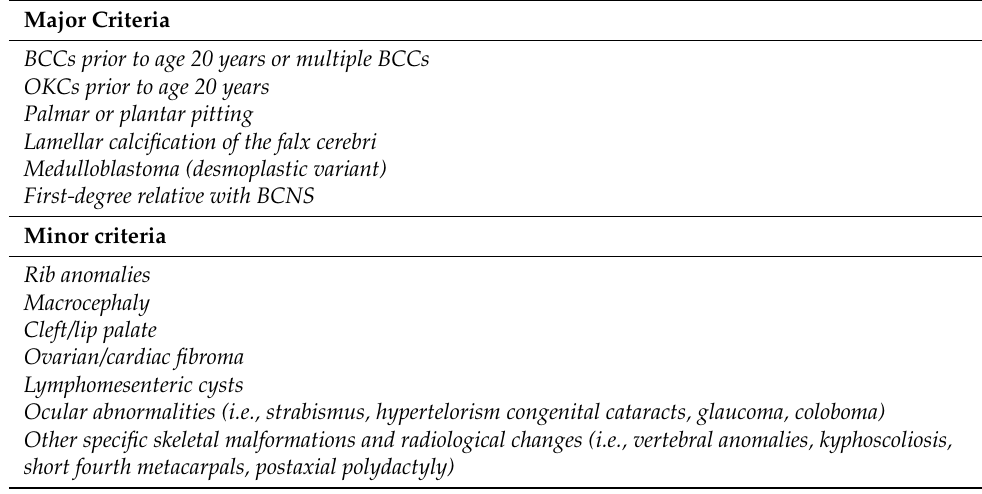
Table 5. Major and minor criteria for BCNS diagnosis